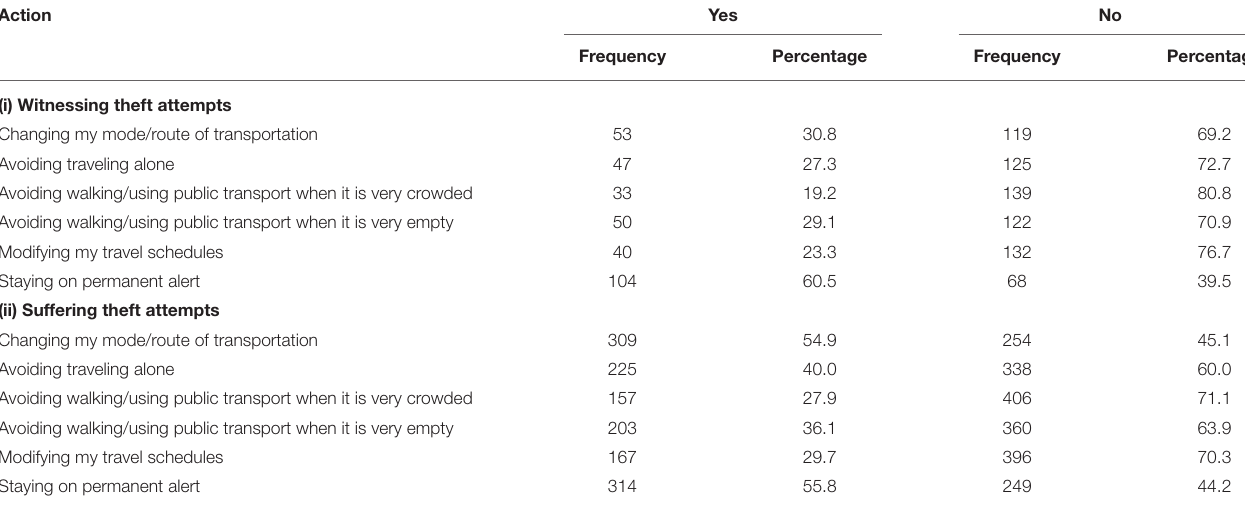
TABLE 5 | Travel actions taken by study participants after witnessing or suffering a theft attempt in city streets and/or public transport.